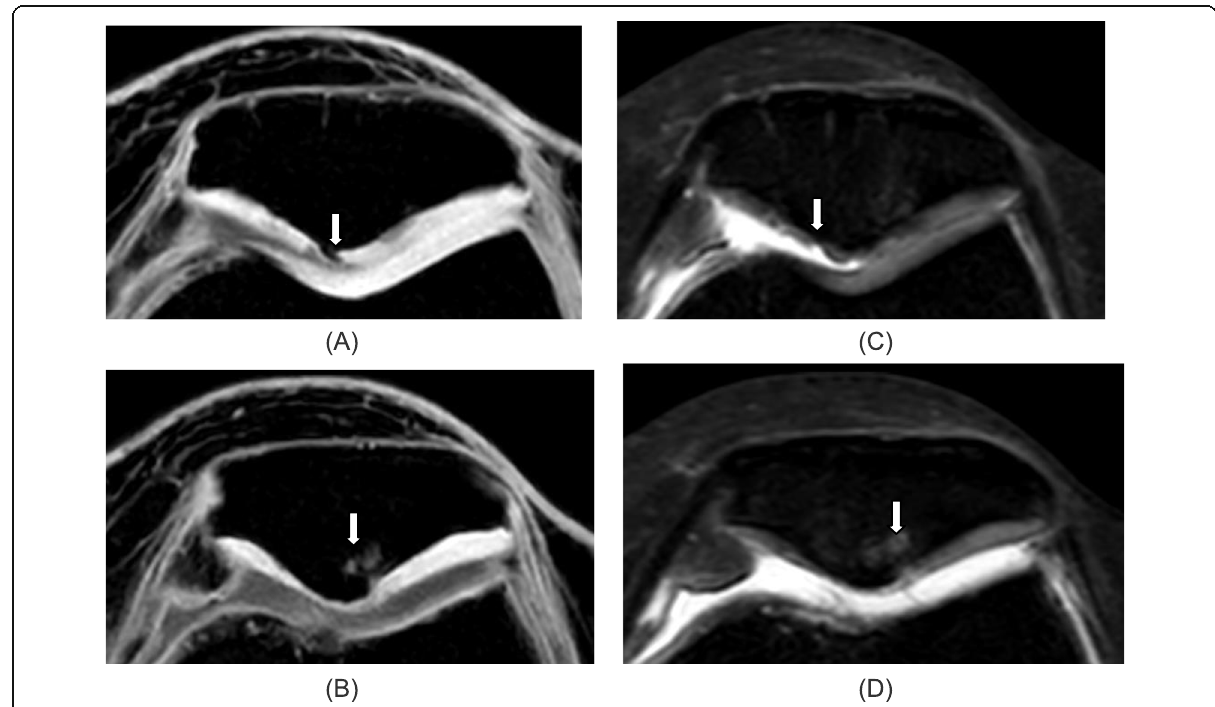
Fig. 3 Sixty-eight-year-old woman with knee pain, two consecutive axial images of 3D WATS-c ( a , b ) showing multiple areas of low signal intensity in medial and lateral patellar articular facet with areas of full-thickness cartilage defect and underlying bony erosion in keeping with grade 3. Corresponding two consecutive images of FS-PD (c , d ) show high signal intensity in cartilage and associated underlying bony